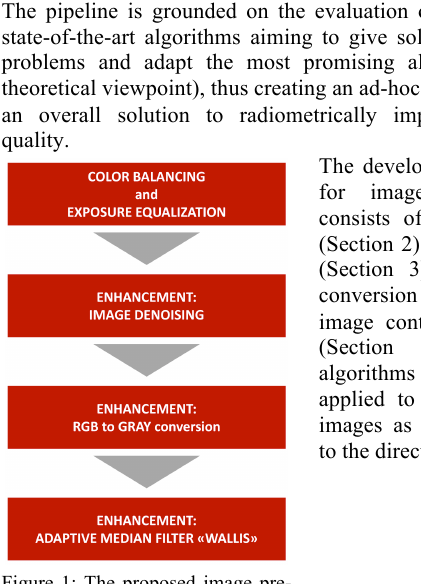
Figure 1: The proposed image pre- processing